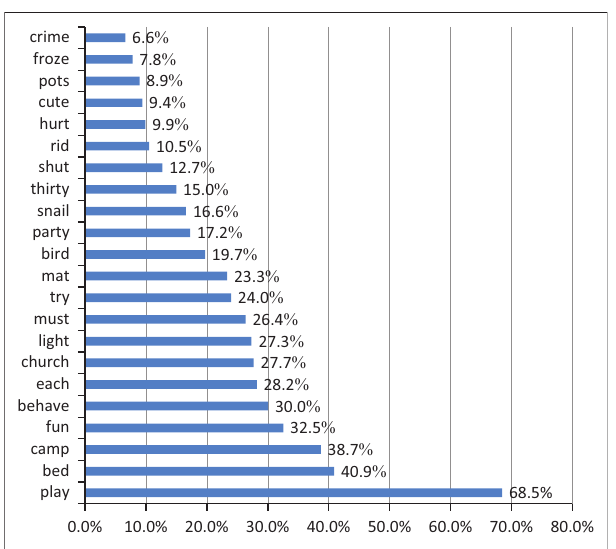
FIGURE 2: Scores for post-test: percentage of learners that spelt the word